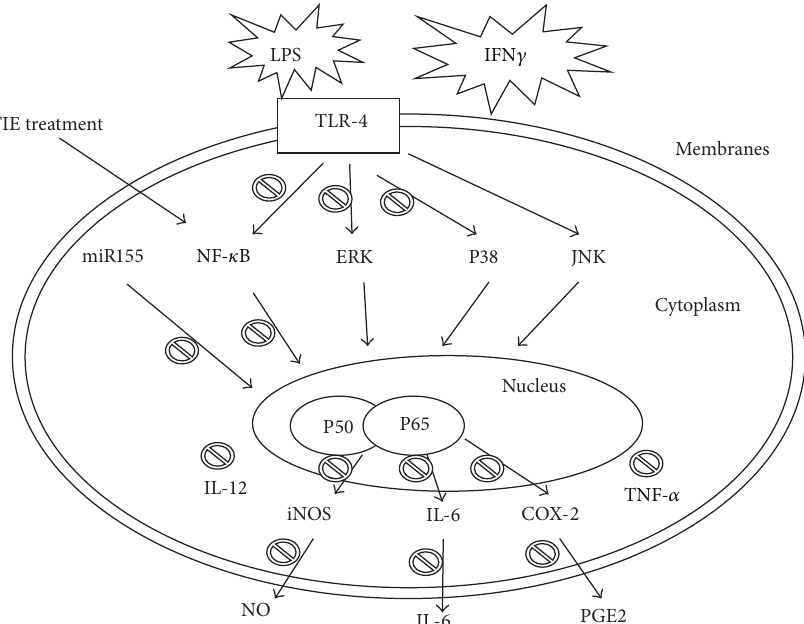
Figure 6: Proposed mechanisms of TIE inhibition of LPS plus IFN 𝛾 induced inflammation in RAW264.7 cells. TIE inactivates MAPK and NF- 𝜅 B signaling pathways in addition to inhibiting expression of miR155, which may result from TIE downregulation of iNOS, COX-2, and IL-6 expression and their production. Arrows indicate the main inflammatory pathway activated by LPS stimulation. The prohibition signs indicate the inhibitory effects of